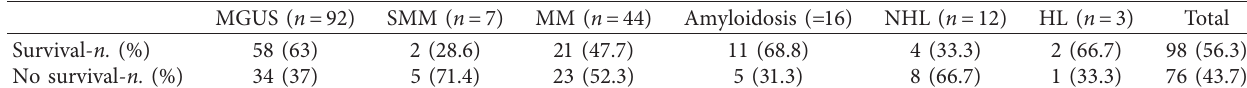
Table 4: Case fatality rate in patients with monoclonal